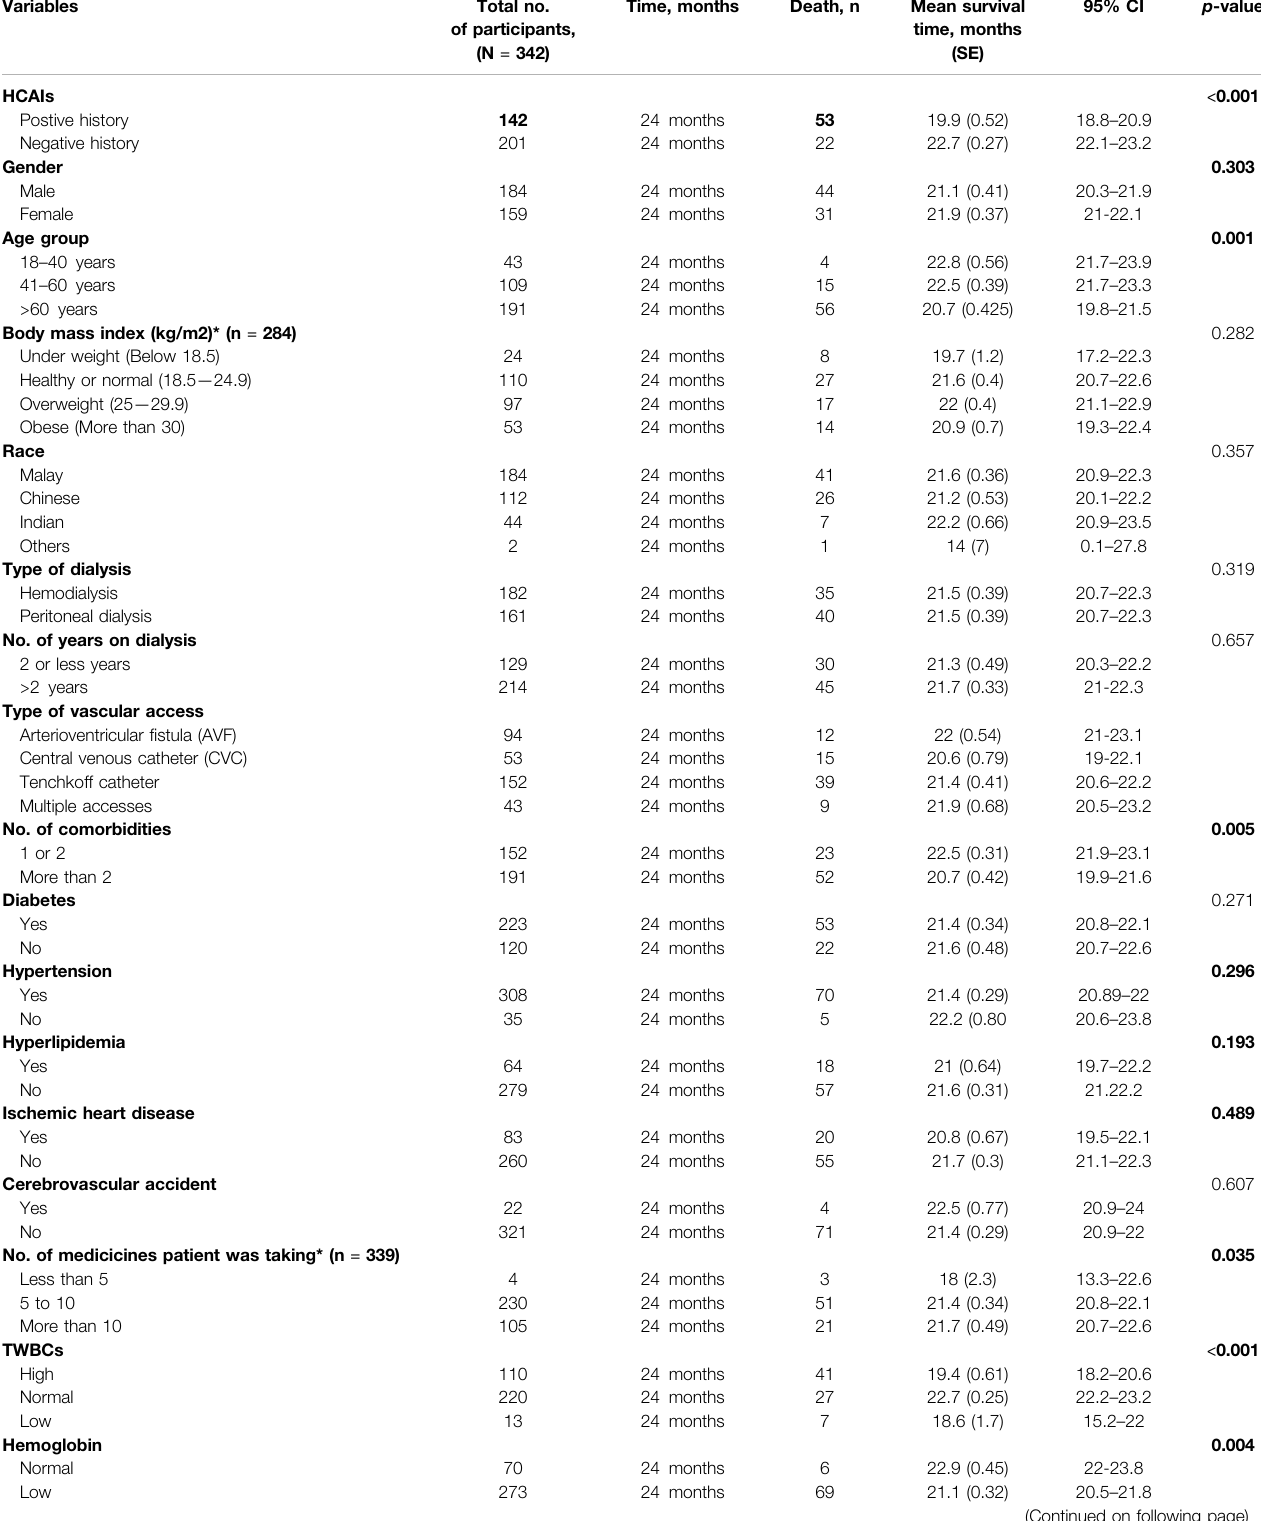
TABLE 2 | Survival trends of study participants through Kaplan-Meier survival analysis.